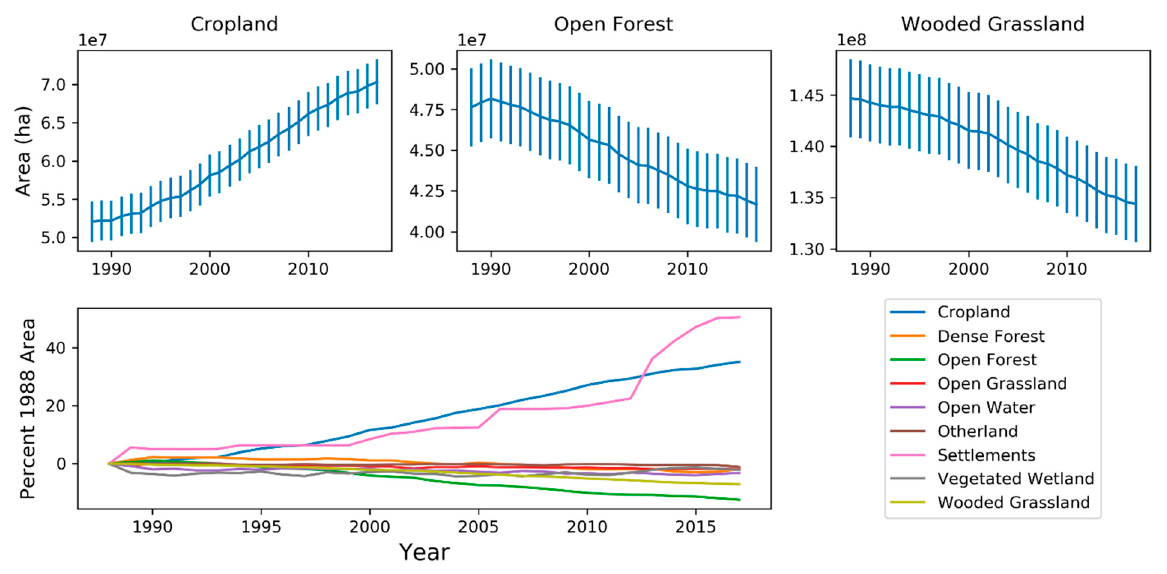
Figure 3. Yearly change in the three classes with the greatest overall change (top), and proportional change in land cover classes across the study domain relative to the area in 1988 (bottom). Standard errors are expressed as vertical lines in the plots of yearly estimated areas.